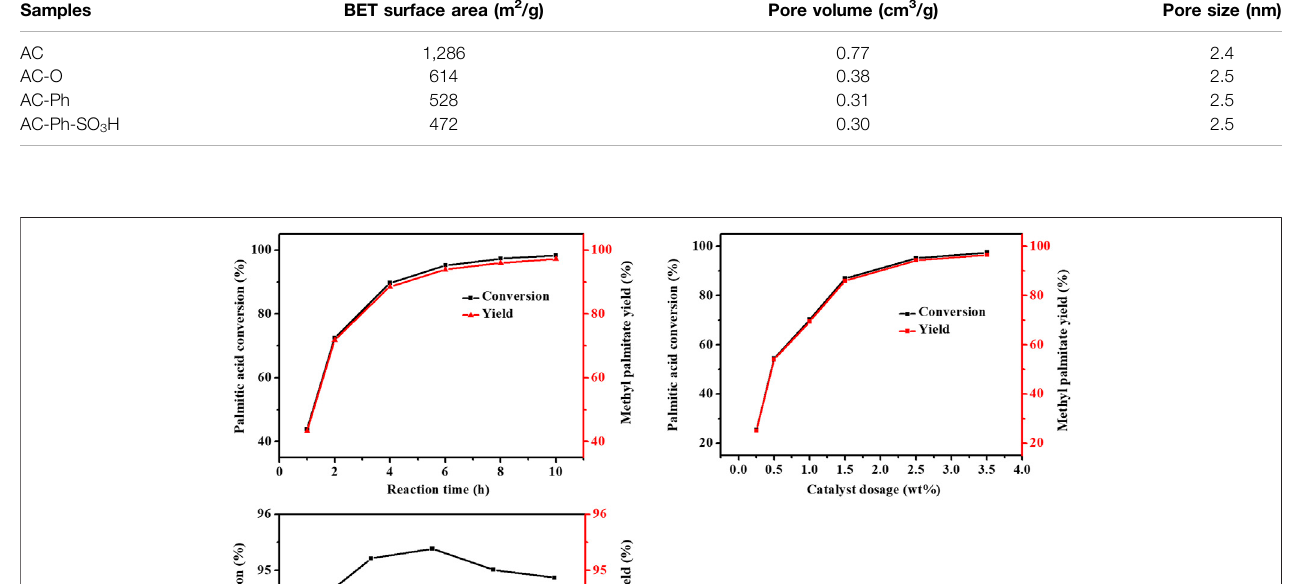
TABLE 5 | BET surface area of AC-N of AC-Ph-SO 3 H and its precursors. Samples